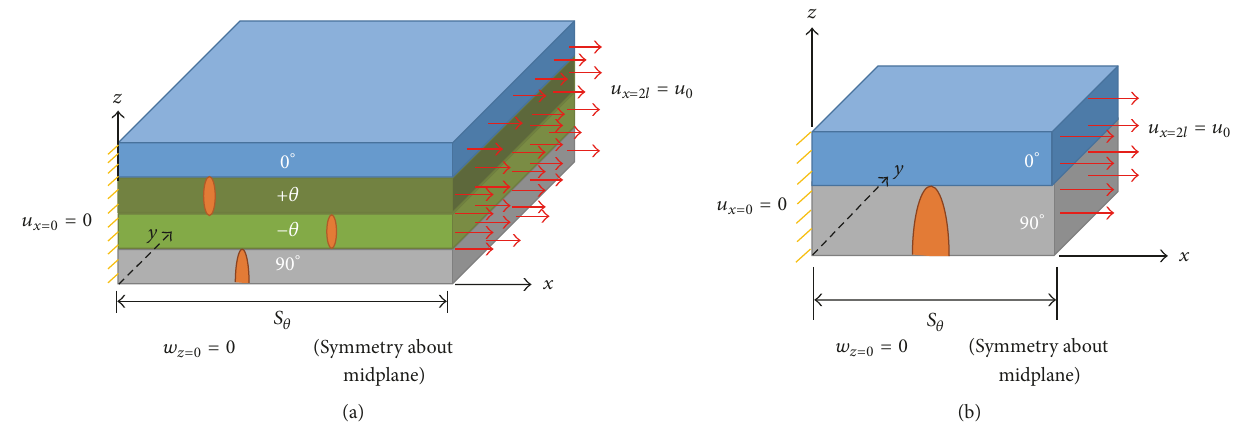
Figure 3: (a) Representative unit cell for a laminate under SDM micromechanics analysis, adapted from [25]. (b) Special case for cross-ply analysis, adapted from